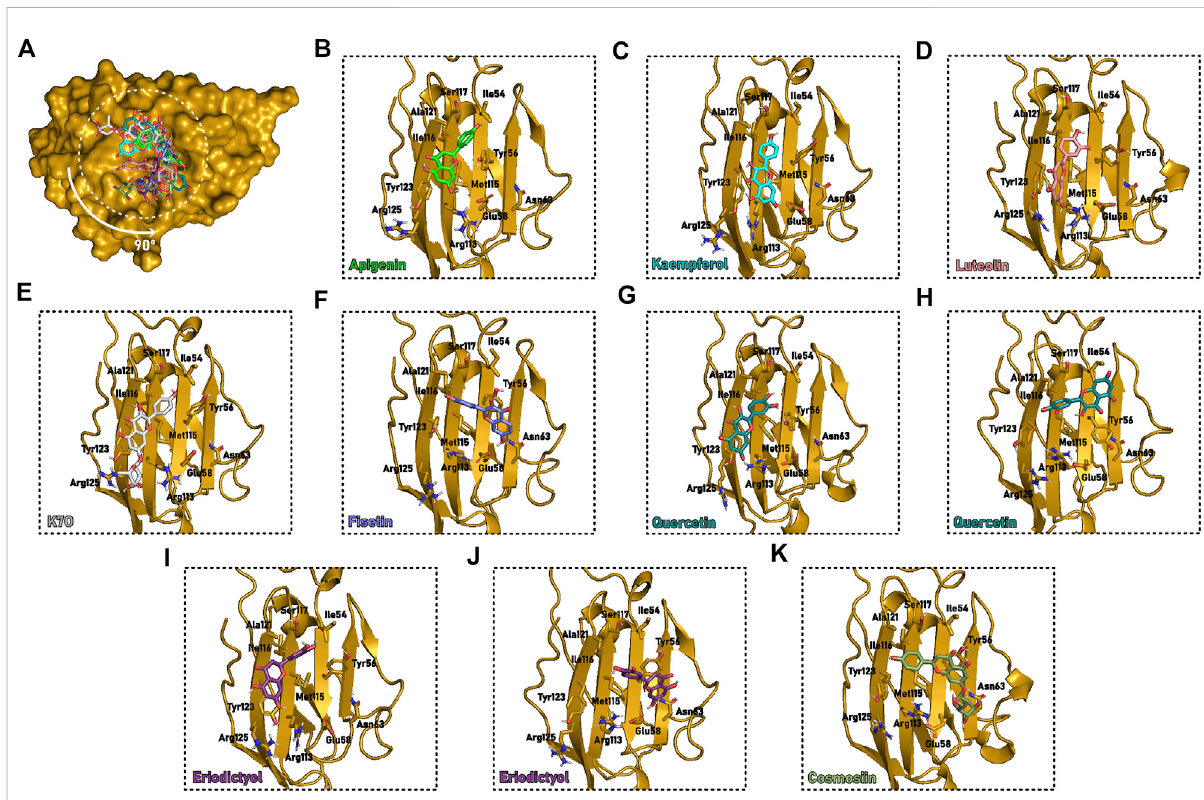
FIGURE 7 FlavonoidsselectedbindingmodeintheinterfacecavityofPD-L1 m attheendofthe50 nscMD. (A) PD-L1 m (yellowsurface)withthemolecules (sticks) superimposed to cavity C6 PD − L1m . (B – L) Detailed description of binding cavity C6 PD − L1m (yellow cartoon) with the interacting residues and moleculeshighlighted(sticks).Theproteinorientationwasrotated90 ° comparedto (A) .Differentcolorsdescribethevarious fl avonoid: (B) Apigenin, green; (C) Kaempferol, cyan; (D) Luteolin, salmon; (E) Kaempferol-7-O-rhamnoside, or K7O, grey; (F) Fisetin, blue; (G,H) Quercetin, teal; (I,J) Eriodictyol, purple; (K) Cosmosiin, dark